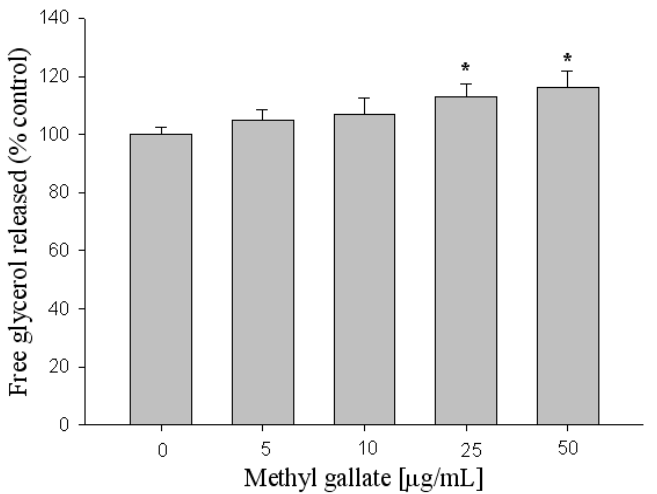
Figure 6. Effect of methyl gallate screened on lipolysis in 3T3-L1 adipocytes. X: methyl gallate, Y: Glycerol content (mM). Values are expressed as mean ± standard deviation of at least three independent from that of the control treatment. * p <